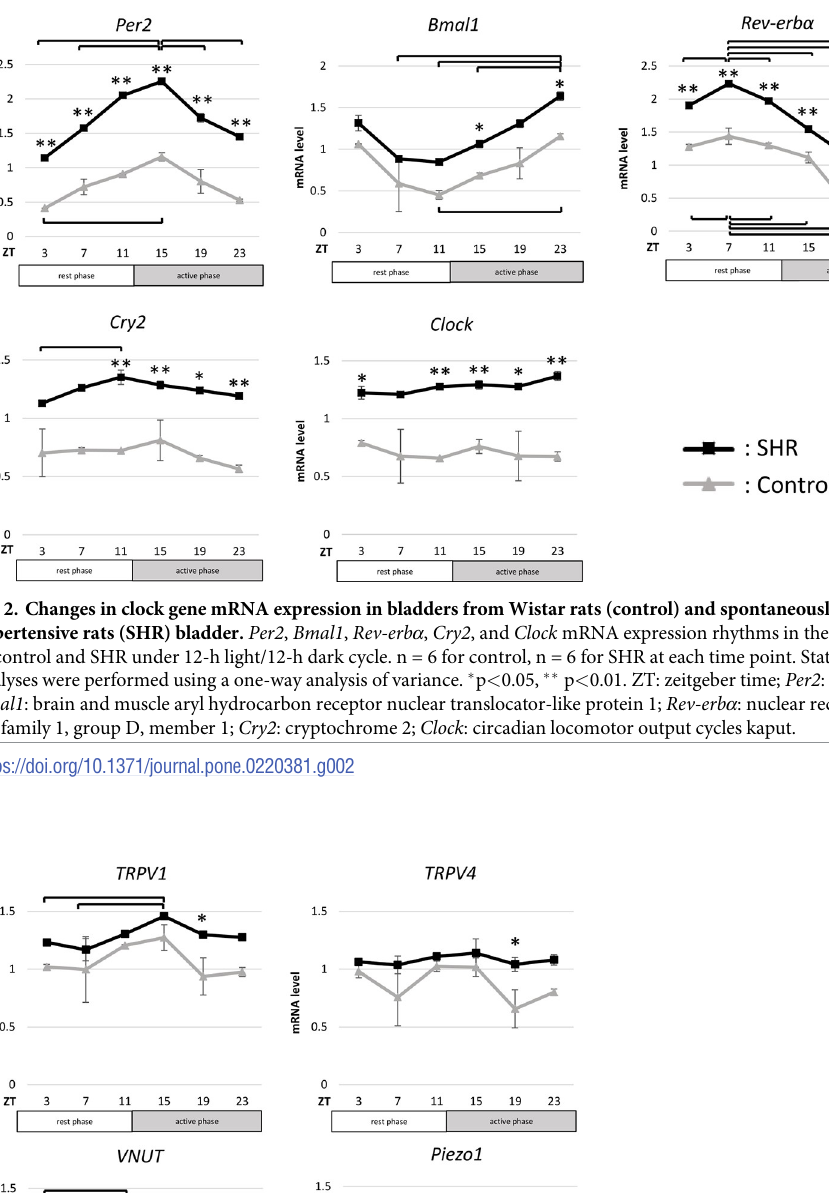
PLOS ONE | https://doi.org/10.1371/journal.pone.0220381 July 25,